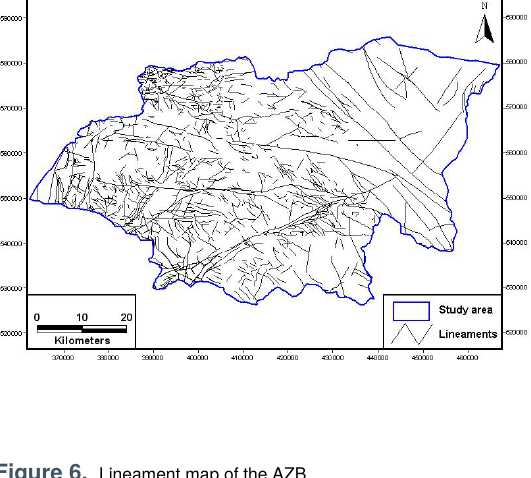
Figure 6. Lineament map of the AZB.